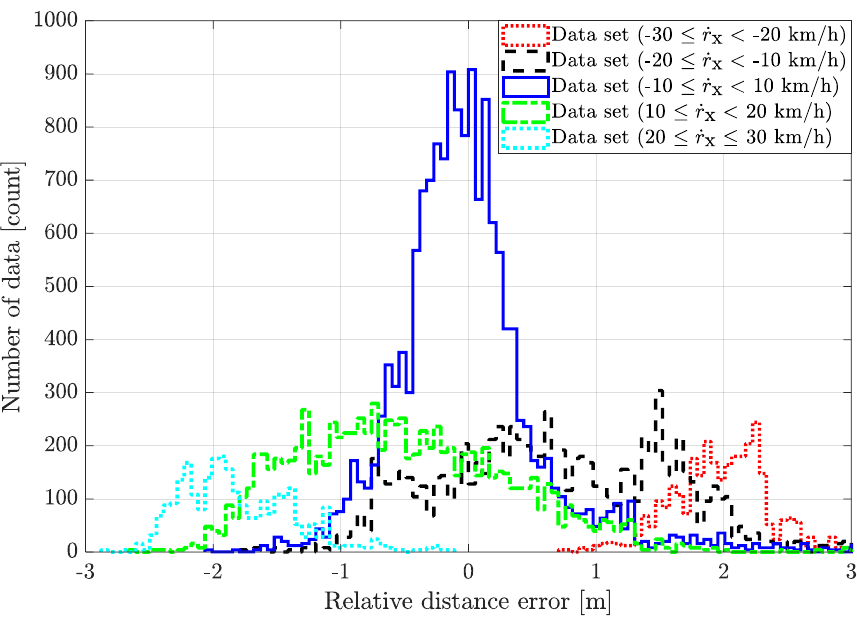
Figure 7. Histogram of the radar relative distance error depending on the vehicle